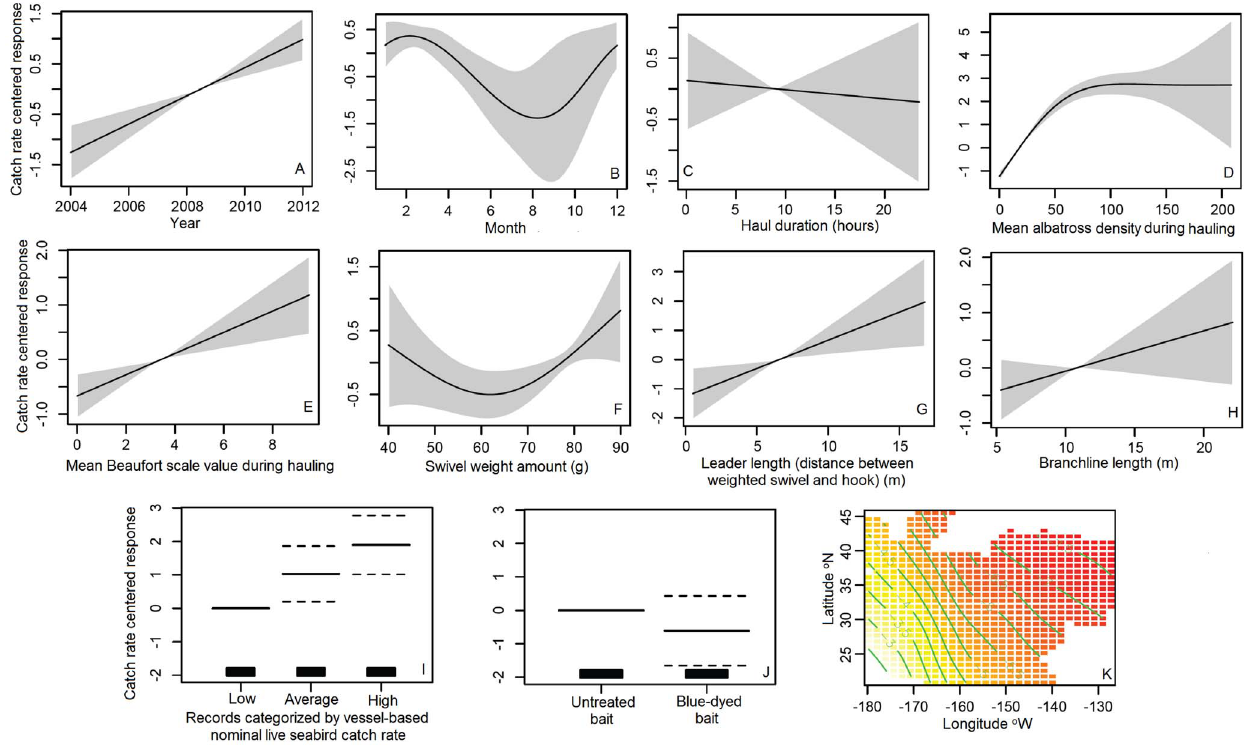
Figure 4. Generalized additive mixed Poisson regression model (GAMM) fitted to live seabird catch in hauls made by the Hawaii longline swordfish fishery (N=11,385 hauls), 4 May 2004 - 11 October 2012. The GAMM explicitly accounts for the effects on the standardized catch rate model for live seabirds of: (A) year, (B) month, (C) haul duration, (D) mean albatross density during hauling, (E) mean value of the Beaufort scale during hauling, (F) amount of the weighted swivel on the branchline, (G) distance between the weighted swivel and hook, (H) branchline length, (I) vessels with low, average, or high nominal live seabird catch rates, (J) untreated vs. blue-dyed fish bait, and (K) two-dimensional spatial (setting location).